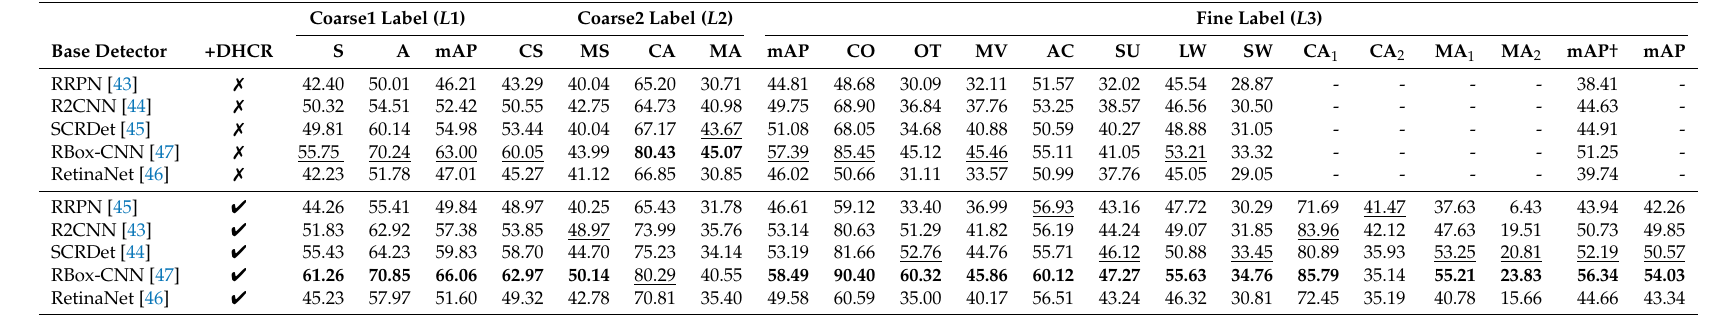
Table 3. Detection results on SkySat test